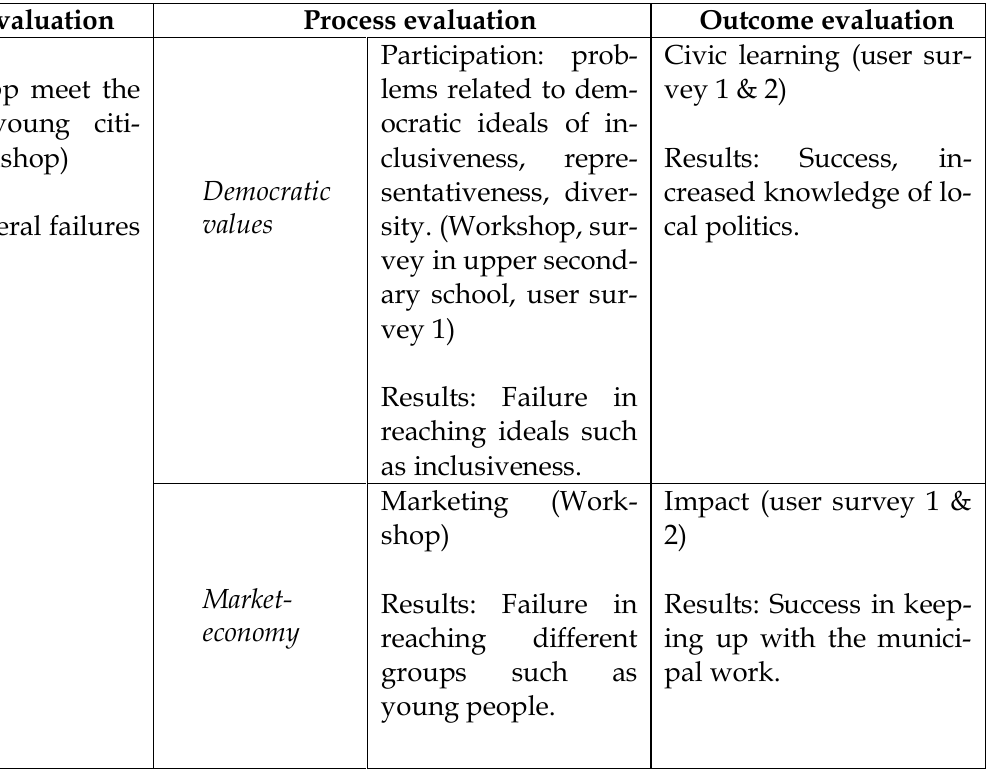
Table 5. Summary of the evaluation